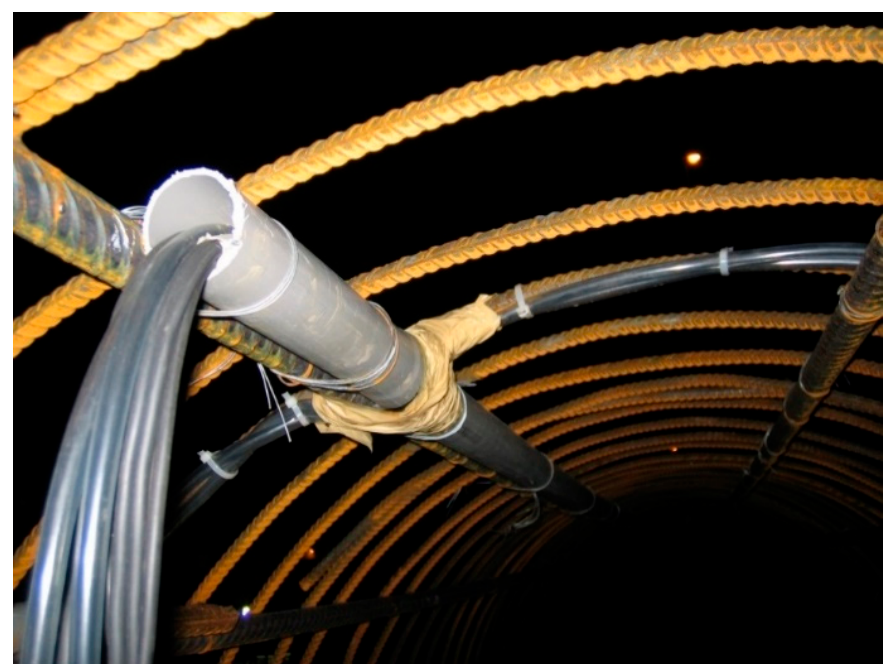
Figure 8. The electrical lead wires from the sensors come to the top.